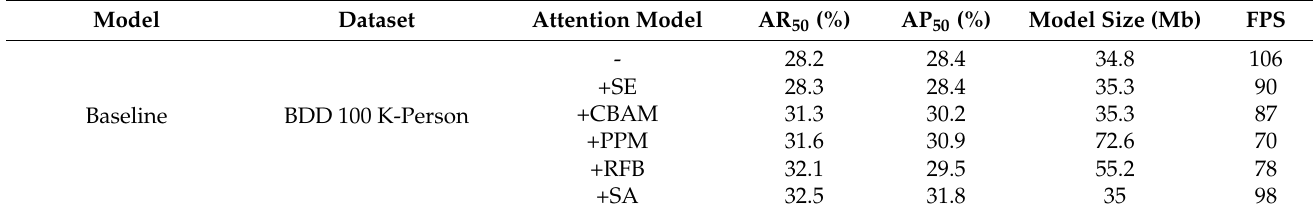
Table 5. Comparative experiments on attention mechanisms for BDD 100 K-Person datasets.